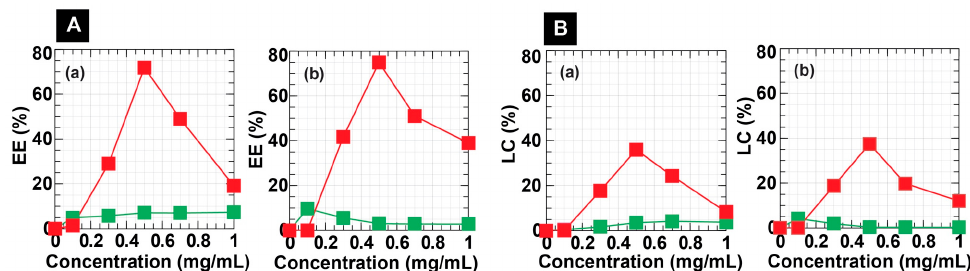
Figure 4. ( A ) Drug encapsulation efficiency (EE) and ( B ) loading content (LC) of ( a ) PTX and ( b